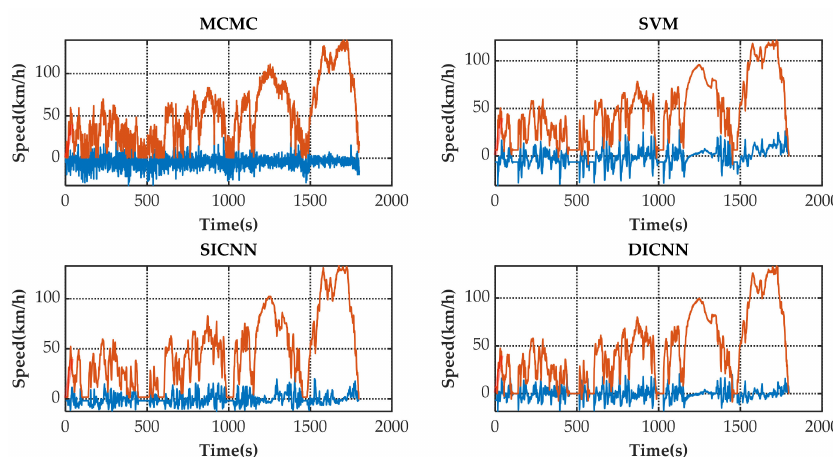
Figure 11. The prediction error (blue) and prediction speed (orange) for the next 5 s.